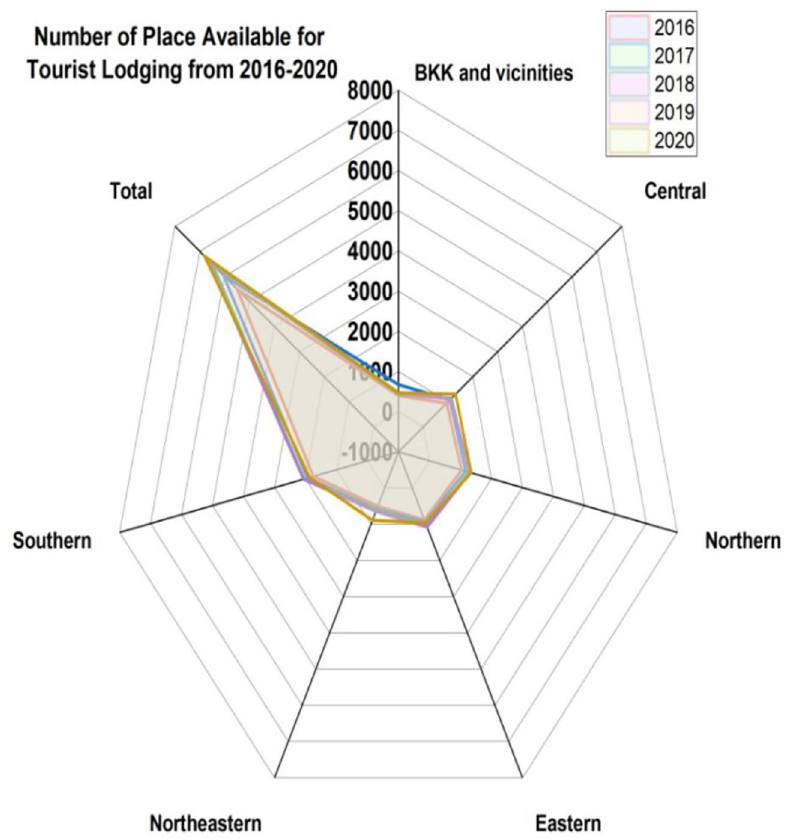
Figure 8. Number of places available for tourist lodging from 2016 to